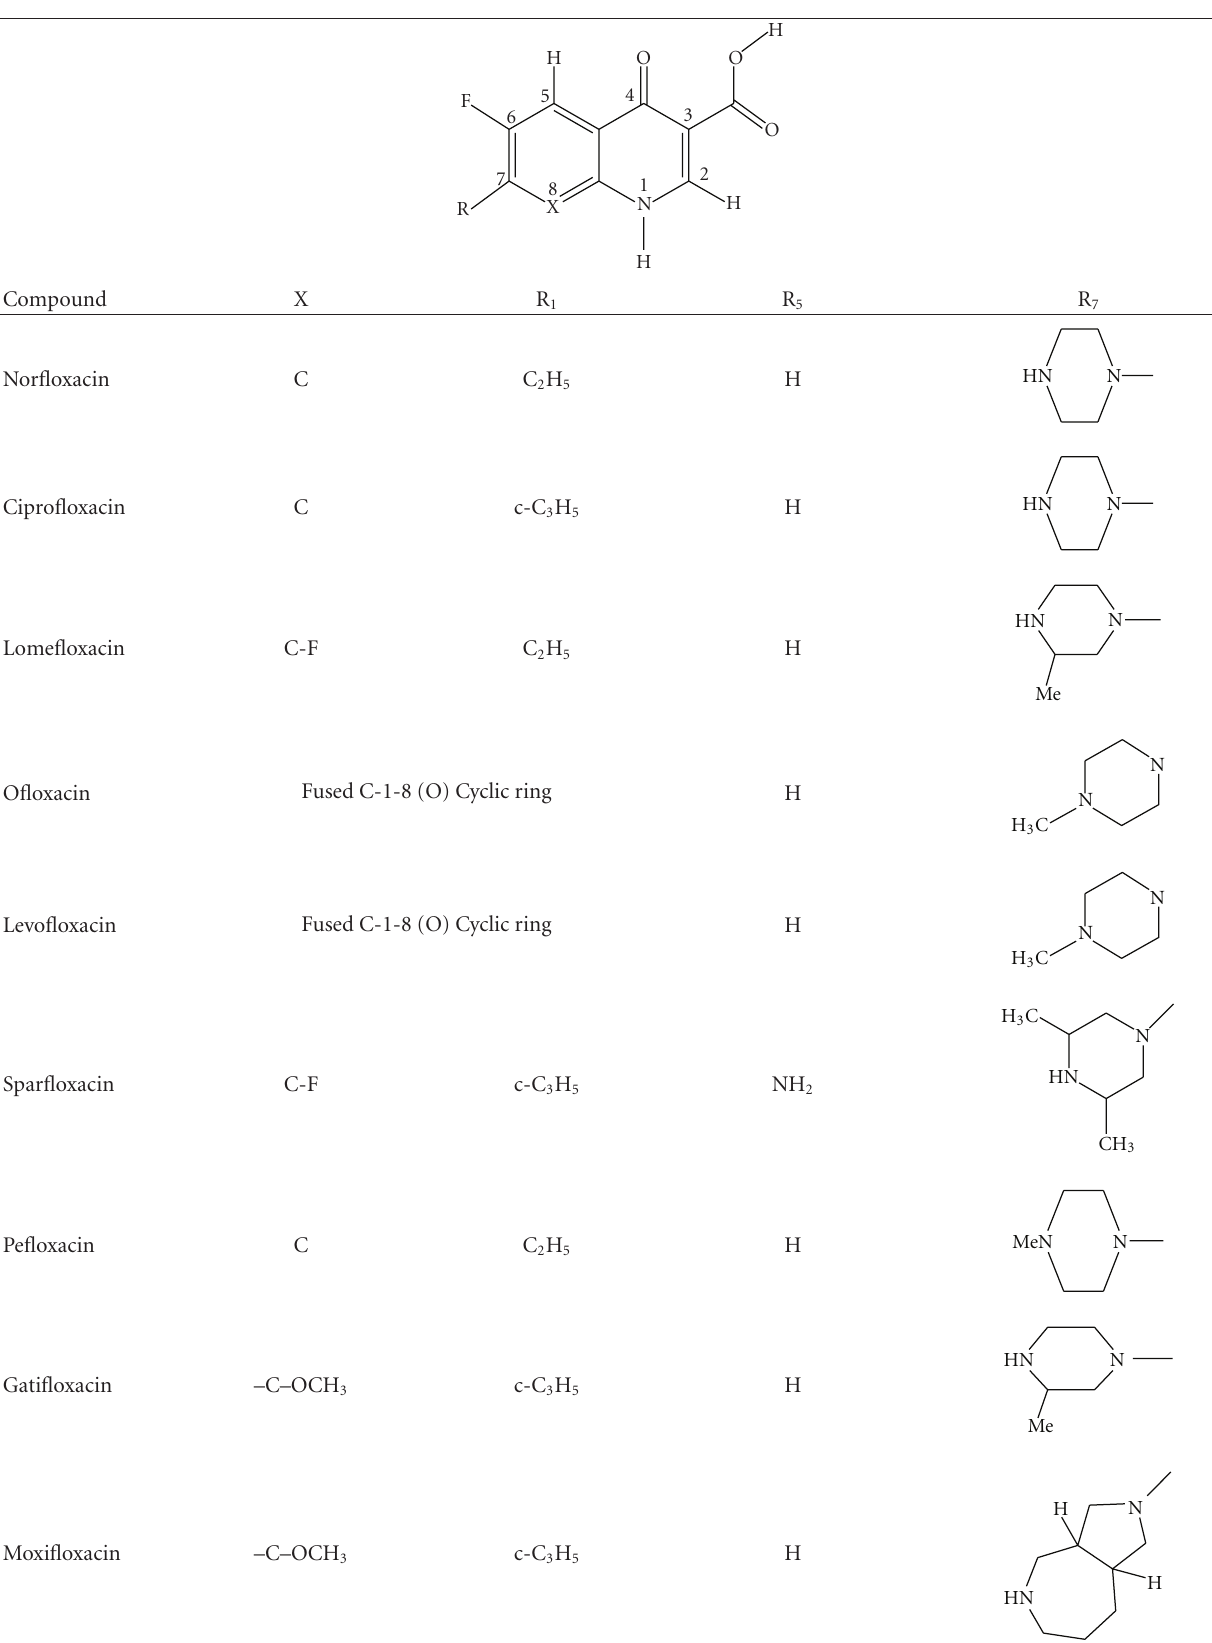
Table 1: Structures of various fluoroquinolones used in the